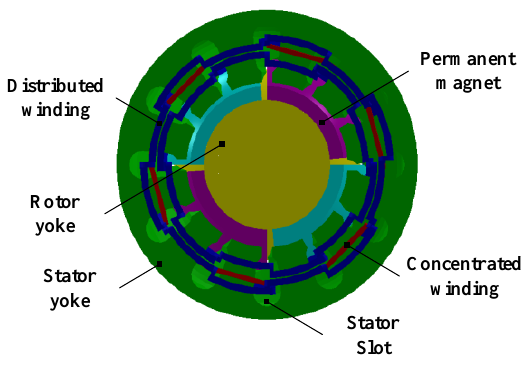
Figure 28. Two-dimensional model of the stator winding scheme.